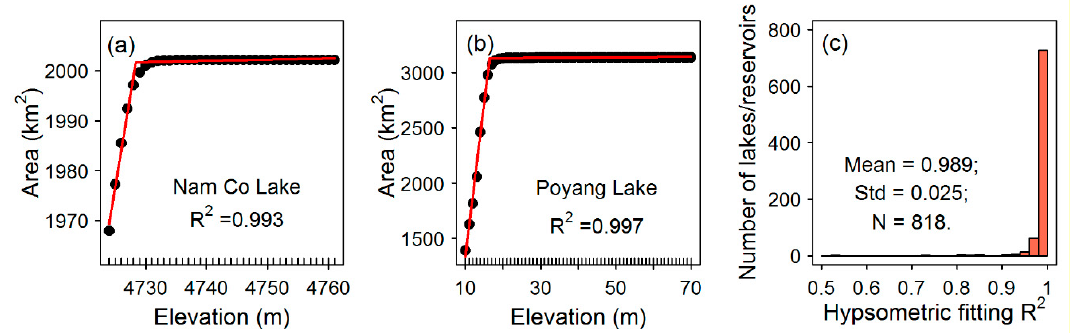
Figure 5. Hypsometric analysis based on the SRTM-DEM data. Derived hypsometric relationships for ( a ) Nam Co Lake and ( b ) Poyang Lake. Both of the two hypsometric functions were fitted with segmented linear relationships. ( c ) Histogram of the fitting R 2 for hypsometric functions for 818 lakes and reservoirs, with mean value of 0.989 and standard deviation of 0.025.